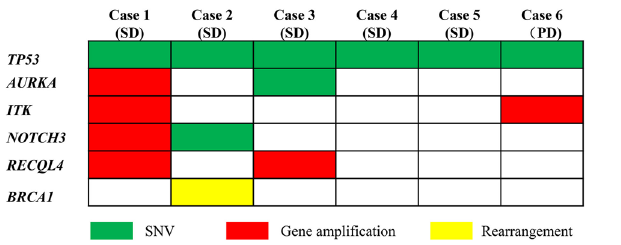
Figure 4. Most frequent mutated genes in 6 platinum sensitive patients. Green represents SNV mutations, red represents gene amplification mutations, and yellow represents rearrangement. SD, stable disease; PD, progressive